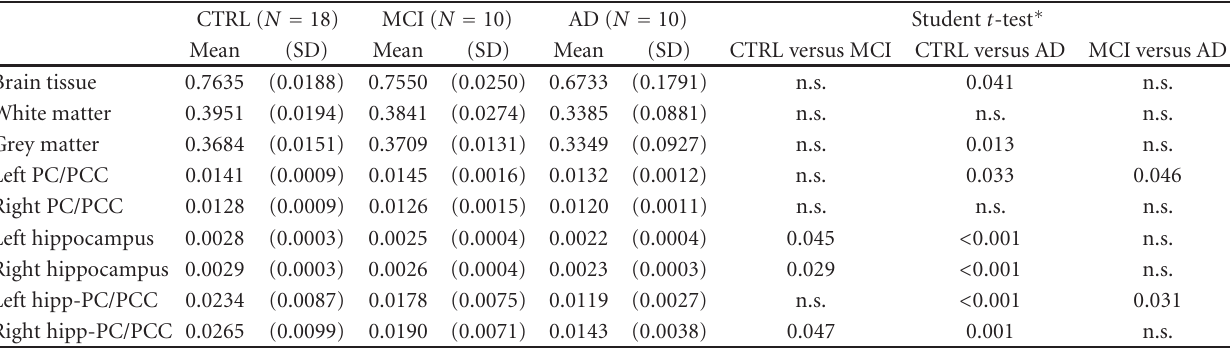
Table 2: Relative volumes in CTRL, MCI, and AD